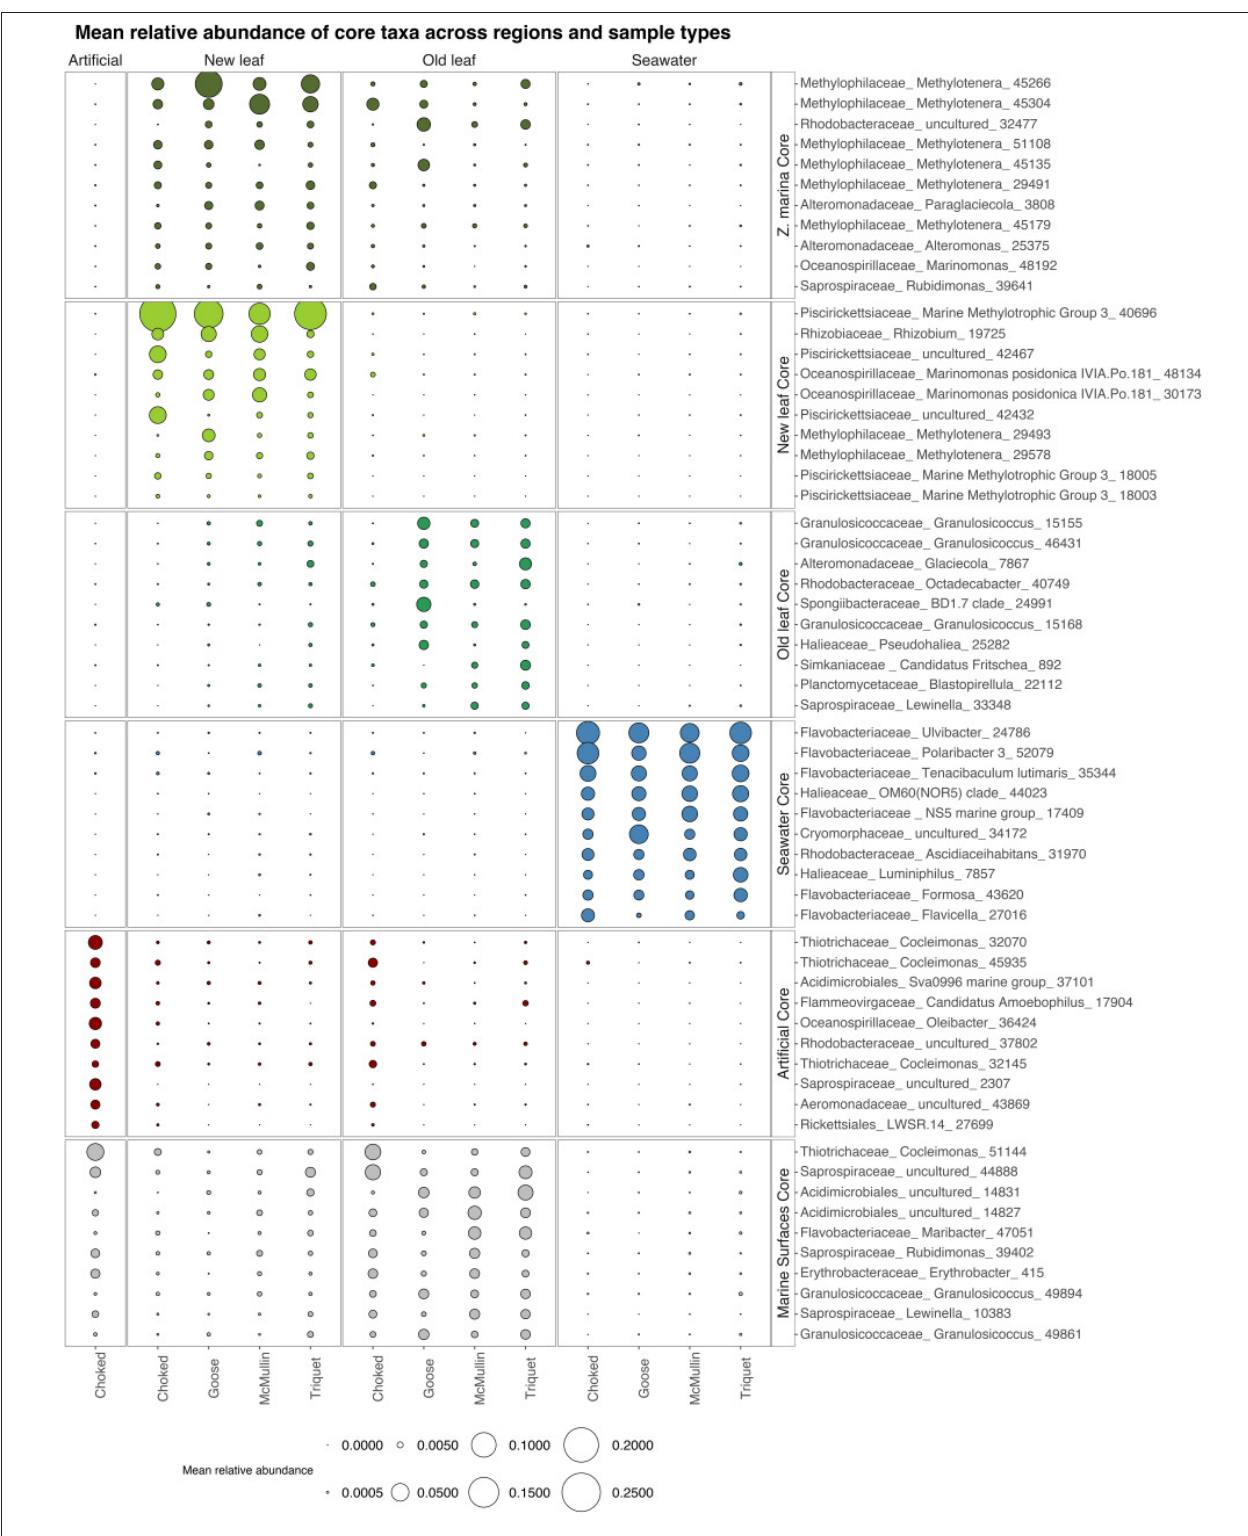
FIGURE 4 | Bubble plot showing the mean relative abundance of the 10 most abundant core taxa across regions and sample types: New growth leaves, Old growth leaves, Zostera marina (core in both new and old growth, here all 11 core taxa are shown), seawater, artificial and marine surfaces (core in both old leaves and artificial seagrass). We considered core taxa the ones significant in Indval analysis, present in at least 50% of the samples and present in all regions. Taxa are labeled by Family names along with the lowest taxonomy level identified.